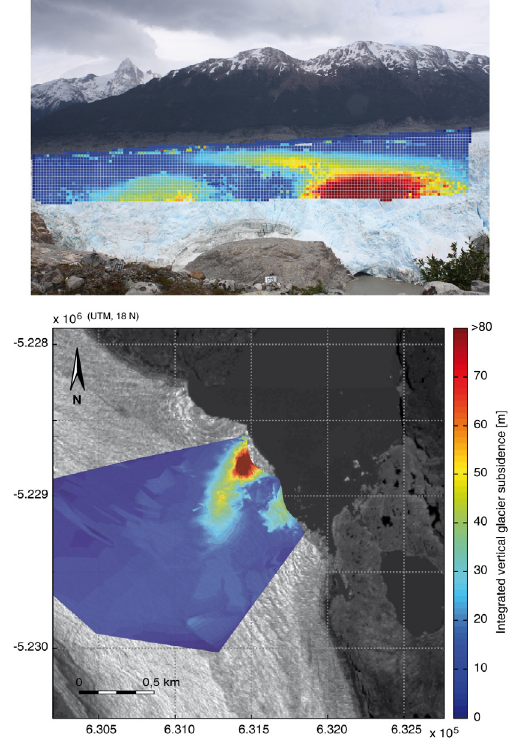
Figure 9. Visualisation of the subglacial channel in January 2010, as projection into a sequence image (top) and a satellite image (bottom). (Source: GeoEye: